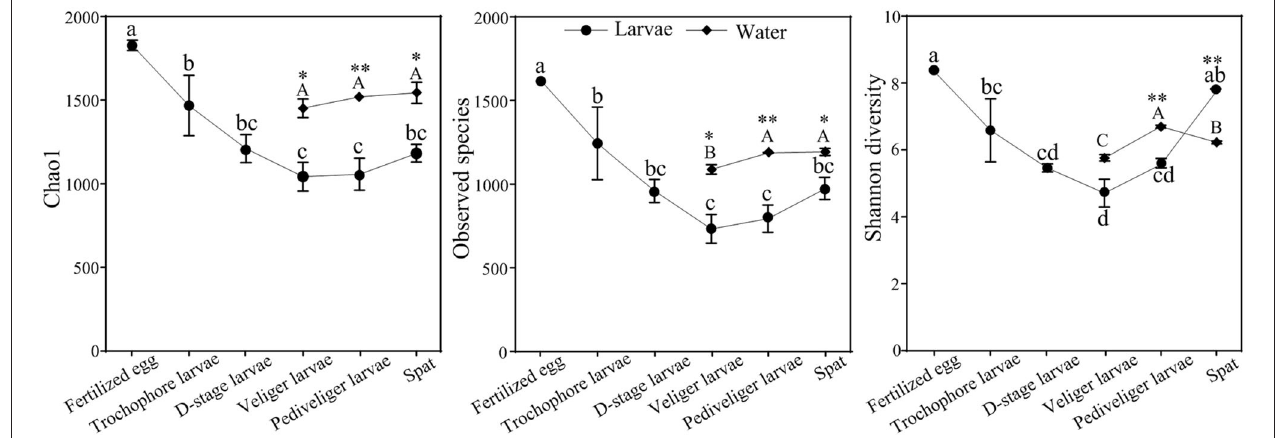
FIGURE 2 | Dynamics of bacterial α -diversity of larvae and rearing water with developmental stages. Data presented represent mean ± standard error values. The different letters show significant differences among developmental stages ( P < 0.05) based on a one-way ANOVA (lowercase for larvae and uppercase for rearing water samples). Significance of differences in the bacterial communities between larvae and rearing water was tested at same developmental stage using independent-sample t -test (* P < 0.05, ** P < 0.01).